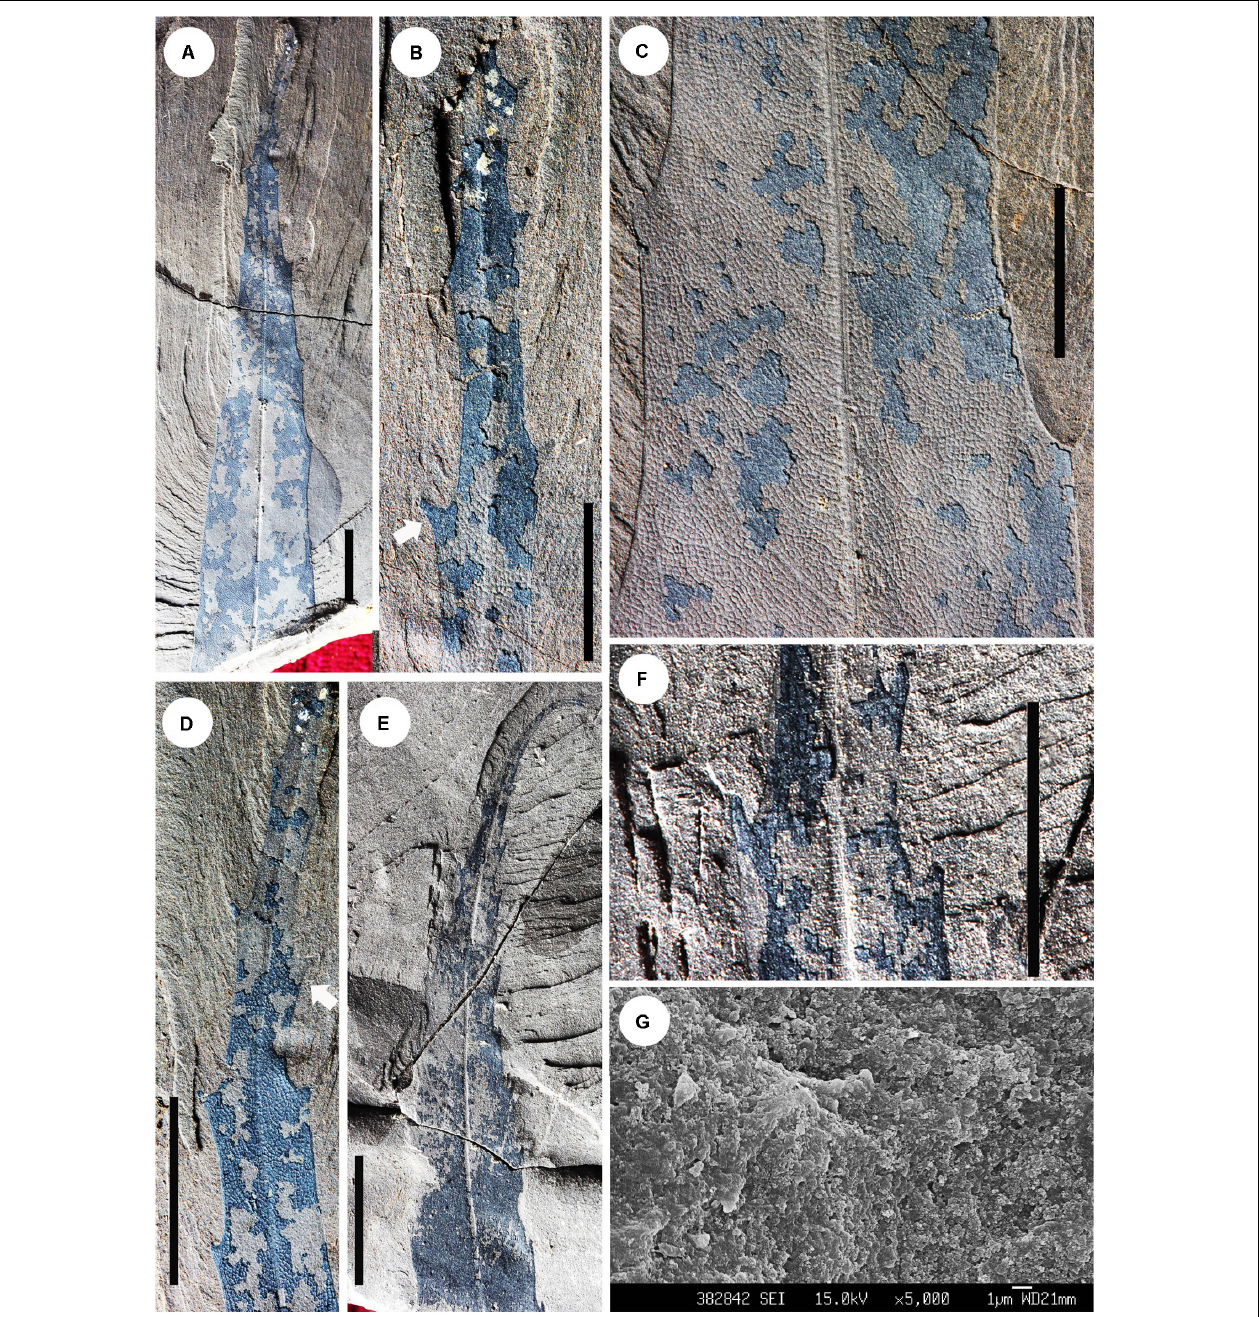
FIGURE 4 | Morphology of Berryophyllum hainanensis sp. nov. (A) Holotype. Specimen No. CC-1244a, showing leaf morphology; (B) specimen No. CC-1244b, arrow indicates the tooth; (C) enlargement of (A) , showing the tooth and venation; (D) enlargement of (A) , showing the apex with teeth (white arrow); (E) paratype. Specimen No. CC-1118a, showing the leaf shape; (F) enlargement of (E) , showing the teeth; (G) granular microstructure on the surface. Scale bars: 10 mm (A,C,D) ; 5 mm (B,E,F)